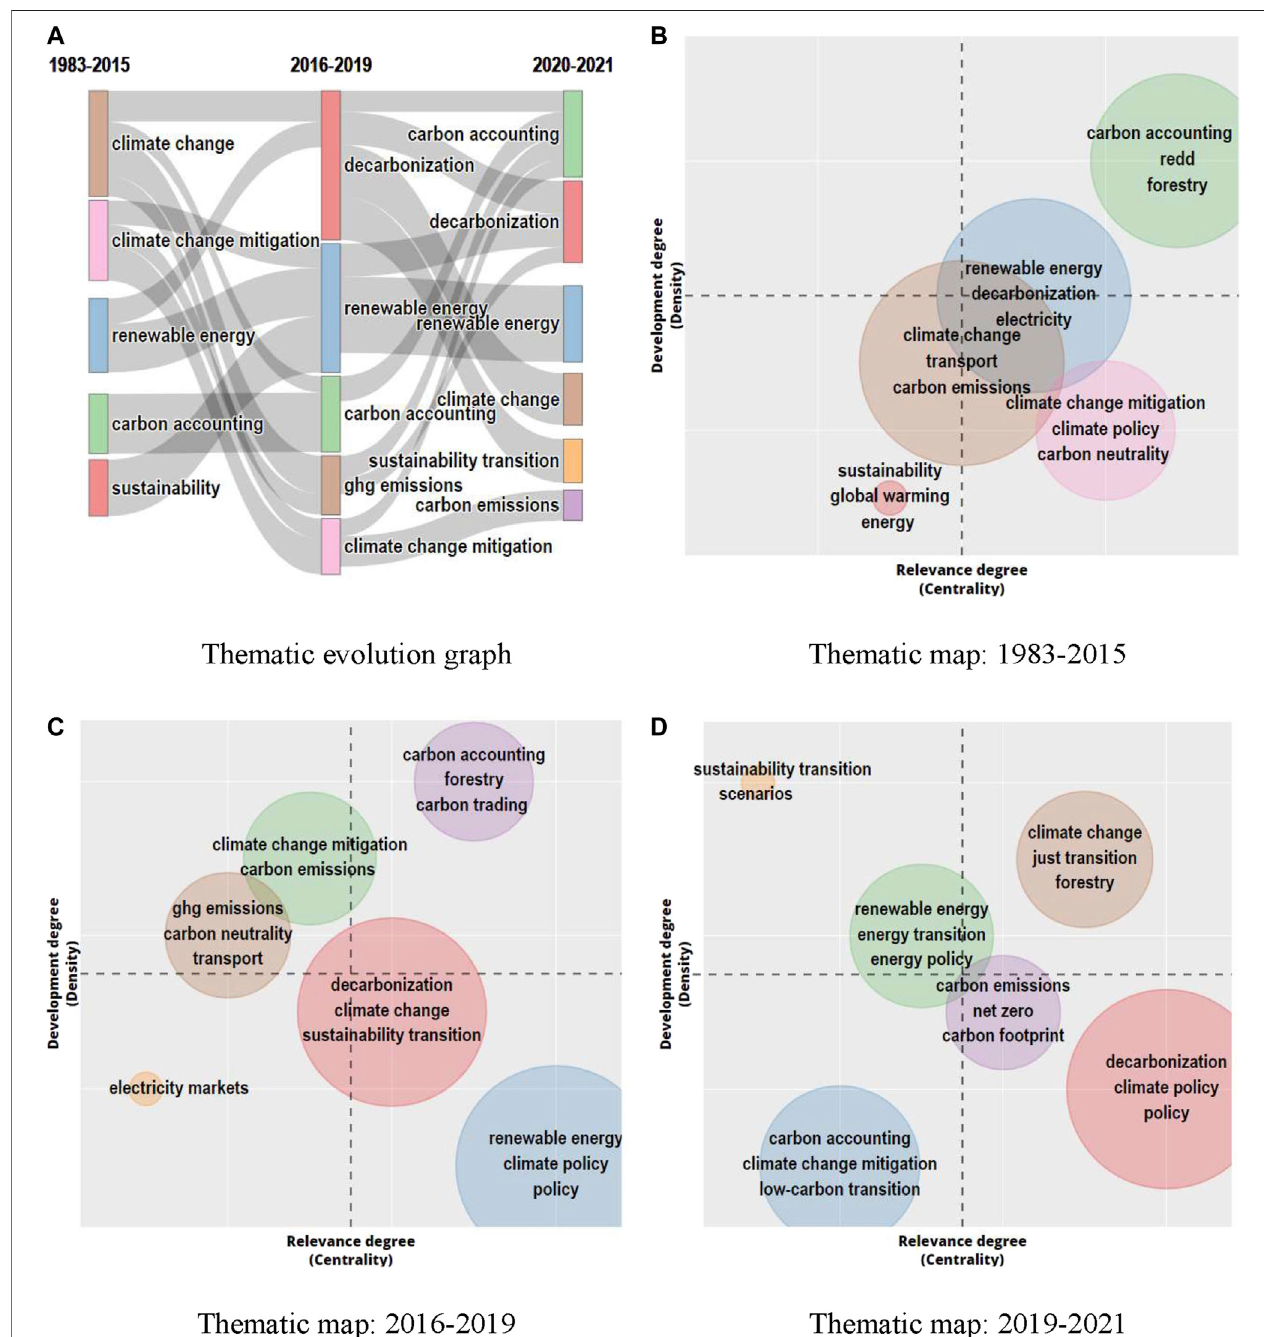
FIGURE 4 | Thematic evolutions: the continued focus on renewable energy and the rise of carbon accounting, decarbonization and sustainability transition. (A) Thematic evolution graph, (B) Thematic map: 1983-2015, (C) Thematic map: 2016-2019, (D) Thematic map: 2019-2021.